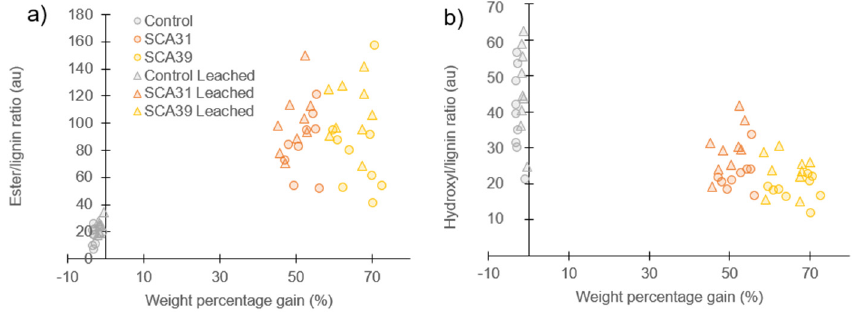
Figure 4. ATR-FTIR peak ratios of leached (triangles) and non-leached (circles) control; 31% sorbitol citric acid and 39% sorbitol citric acid modified samples. ( a ) Ester peak (1730 cm − 1 ) relative to lignin peak (1508 cm − 1 ); ( b ) Hydroxyl peak (3325 cm − 1 ) relative to lignin peak (1508 cm − 1 ).